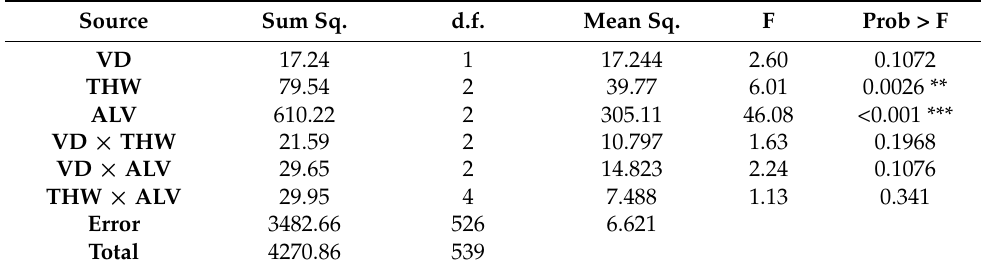
Table 5. Three-way ANOVA results on takeover control